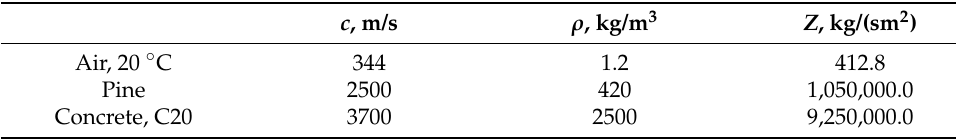
Table 1. Acoustic characteristics of